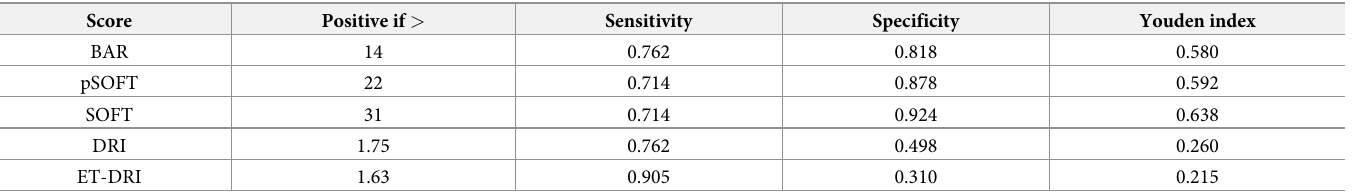
While the major focus of our study was on short-term outcomes, we also performed Kaplan- Meier curve analyses to indicate differences in long-term (5-year) survival. The 5-year cumula- tive patient survival rate was 76% for BAR � 14 vs. 69% for BAR > 14 (p = 0.042), 77% for pSOFT � 22 vs. 57% for pSOFT > 22 (p < 0.001), 77% for SOFT � 31 vs. 50% for SOFT > 31 Table 5. Specificity, sensitivity, and Youden indices to determine the best cutoff points for the BAR, pSOFT, SOFT, DRI, and ET-DRI scores based on 90-day mortality.